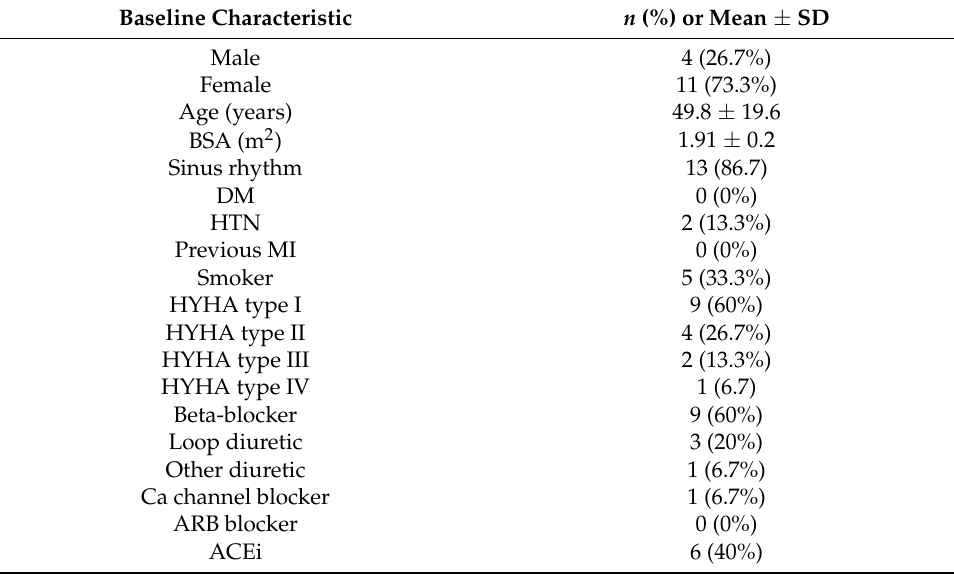
Table 1. Demographic variables of the 15 patients included in this study.